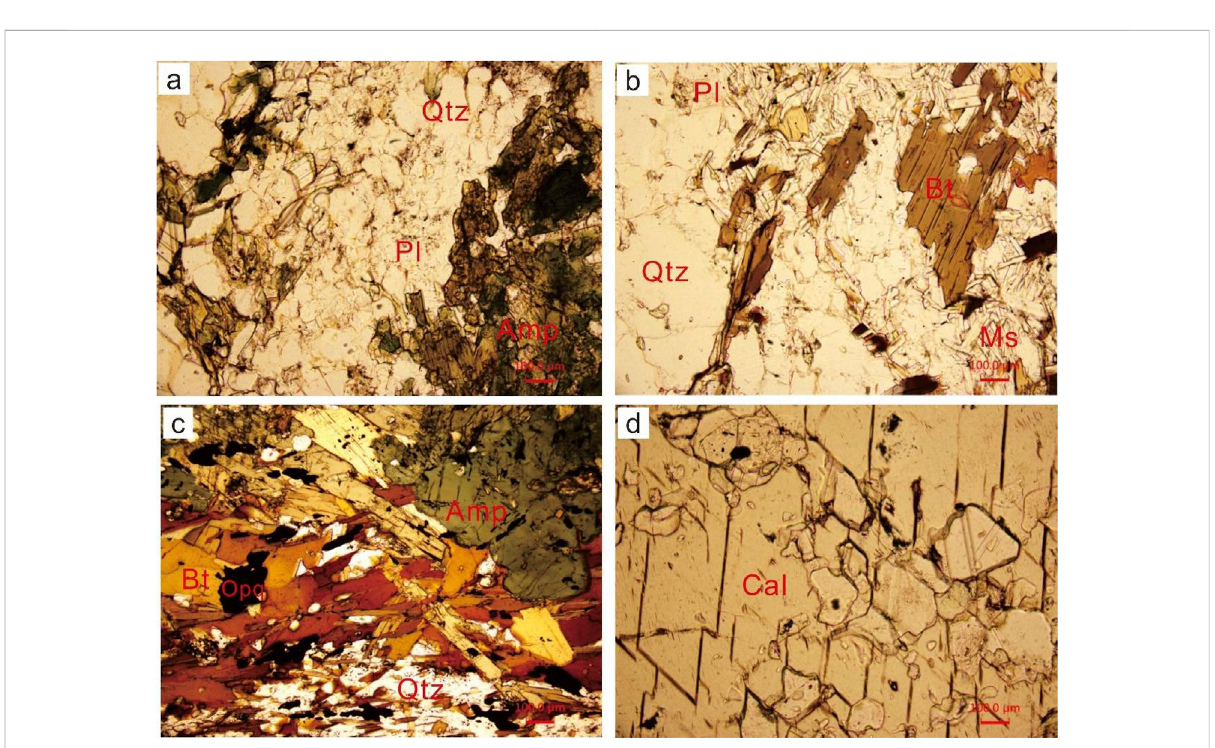
FIGURE 3 Microphotograph of metamorphic rocks in the Xunyangba area. (A) Amphibolite (plane-polarized light); (B) mica schist (plane-polarized light); (C) biotite schist (plane-polarized light); (D) marble (plane-polarized light). (Note: Mineral abbreviations that appear in this article are as